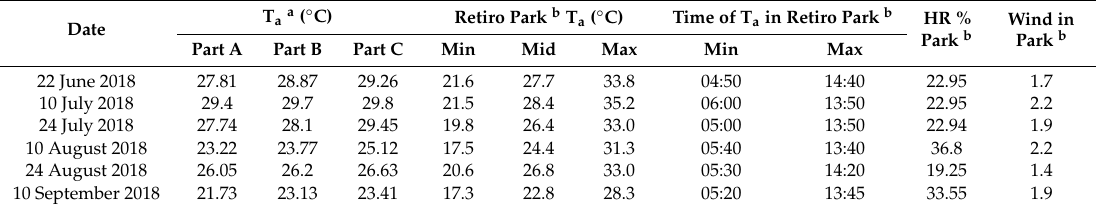
Table 6. Mean values for air temperature (T a ), in the three intersection (10:40–12:10 CET) and values for air temperature (T a ), relative humidity (RH) and wind velocity (W) in the Retiro Park on all the measurement days.